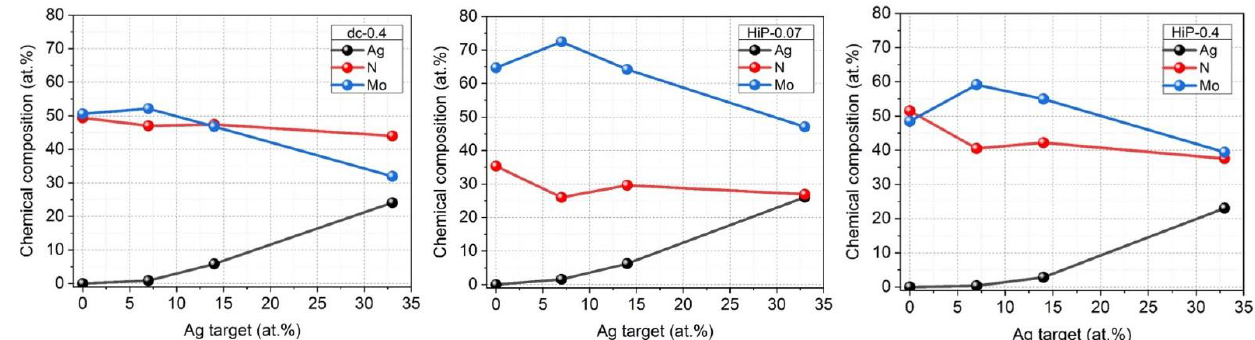
Figure 5. Chemical composition (WDX) of Mo and MoN-Ag coatings from the 3 different sputtering processes.